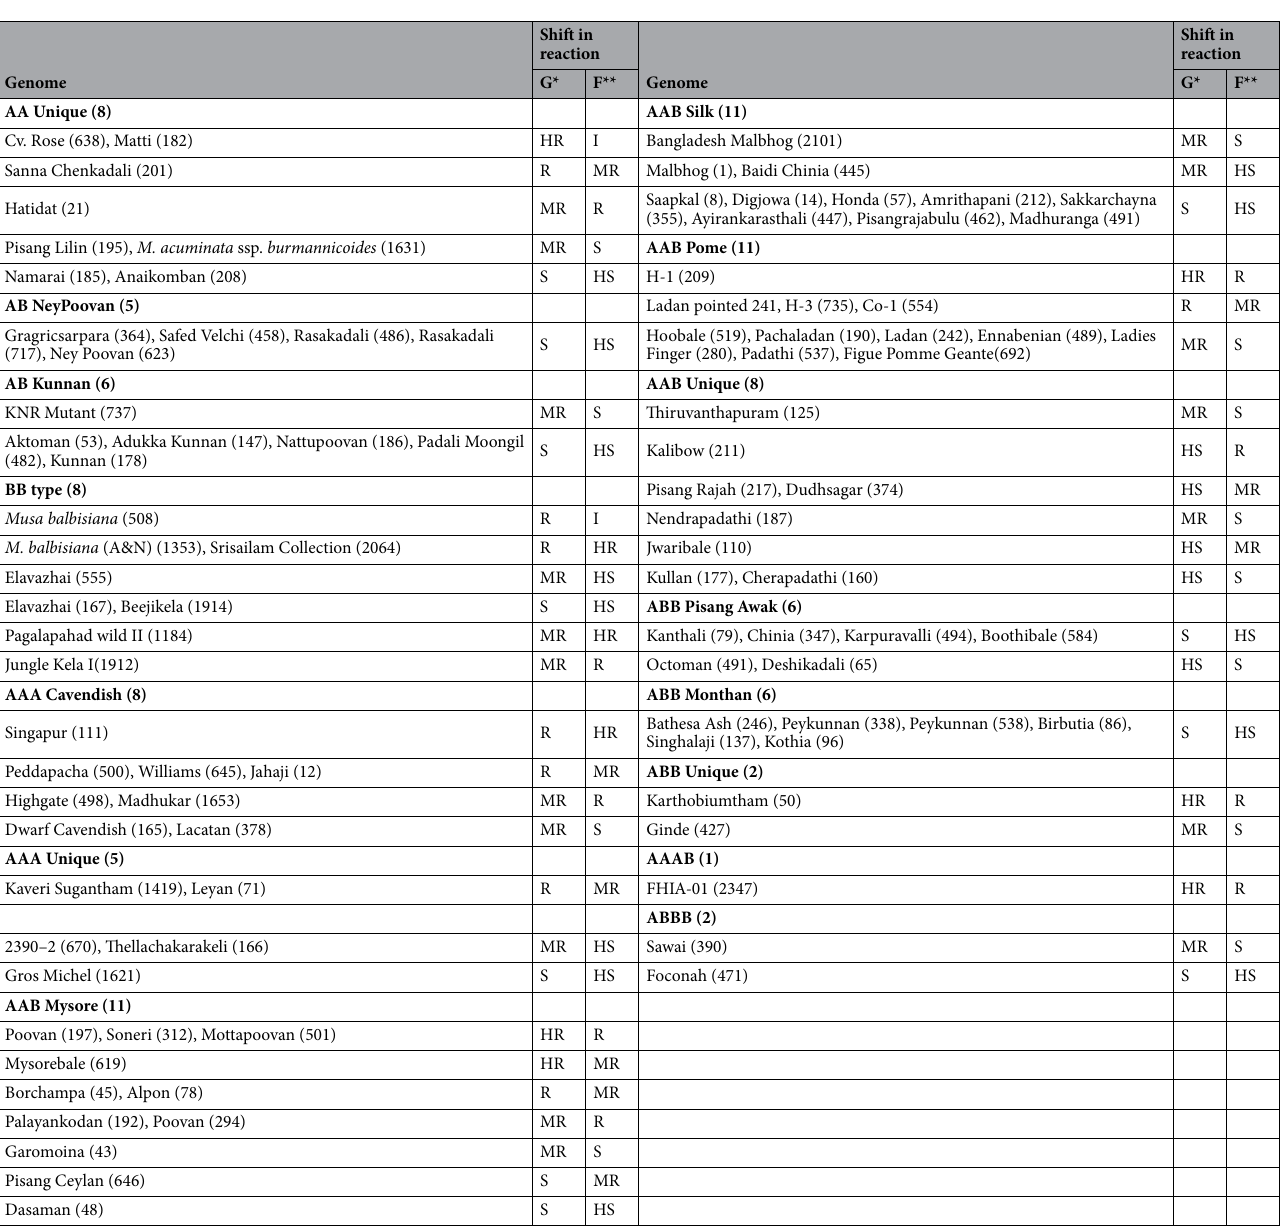
Table 5. Genotypes showing shift in reaction for Foc race 1 (VCG 0124) from glasshouse to field conditions. *F: Field conditions (Hot spot); G: Glasshouse conditions. I-Immune; HR-Highly resistant; R-Resistant; MR-Moderately resistant; S-Susceptible; HS-Highly